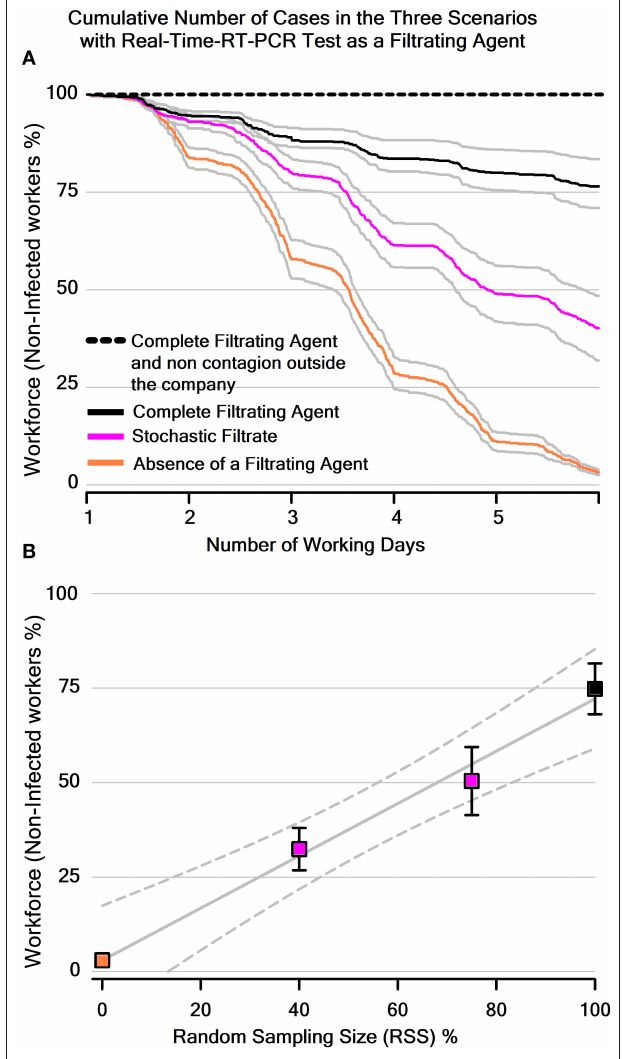
FIGURE 5 | Cumulative mean number of cases of non-infected workers (“workforce”) in the three scenarios: absence of a filtrating agent, complete filtrating, and stochastic filtrate. (A) The same as in Figure 4 , but for the workforce (as a percentage of the total number of workers). (B) Workforce vs. random sampling size (RSS in %) employed to generate the three scenarios in the Python simulation. Note that a higher RSS ensures a higher workforce (with 95% confidence intervals, dashed lines). Vertical bars represent the standard error. The graph also shows that the stochastic process is between two deterministic situations: “absence of a filtrate agent” and “complete filtrate agent.” The filtrate agent could be the